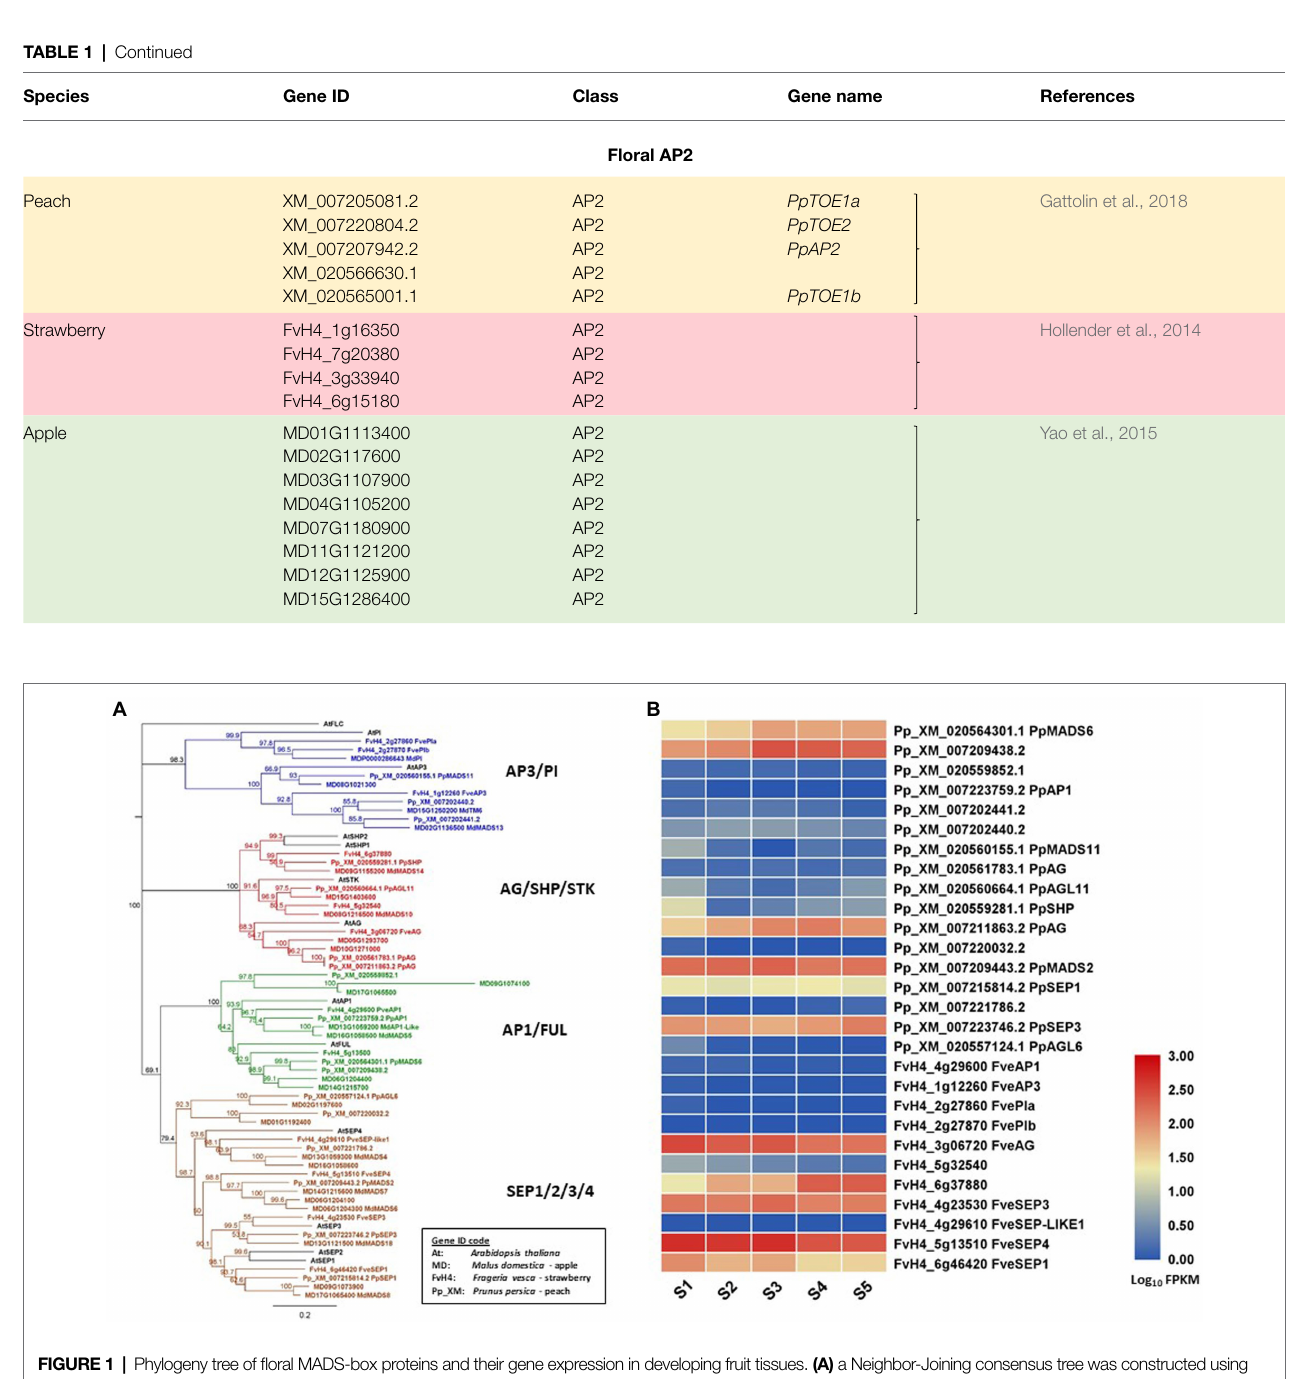
FIGURE 1 | Phylogeny tree of floral MADS-box proteins and their gene expression in developing fruit tissues. (A) a Neighbor-Joining consensus tree was constructed using Geneious software (v10.0.9) with 1,000 bootstrap replicates after protein sequences were aligned using Geneious Alignment software (v10.0.9). MADS-box protein sequences downloaded from the reference genome of apple (Daccord et al., 2017), peach (Verde et al., 2013), strawberry (Edger et al., 2017), and Arabidopsis. The Arabidopsis protein IDs are AT1G69120.1 (AtAP1), AT5G60910.1 (AtFUL), AT5G20240.1(AtPI), AT3G54340.1 (AtAP3), AT4G18960.1 (AtAG), AT3G58780.1 (AtSHP1), AT2G42830.1 (AtSHP2), AT4G09960.1 (AtSTK), AT5G15800.1 (AtSEP1), AT3G02310.1 (AtSEP2), AT1G24260.1 (AtSEP3), AT2G03710.1 (AtSEP4), and AT5G10140.1 (AtFLC). (B) a heatmap shows the expression patterns of floral MADS-box genes in fruit tissues of peach and strawberry at five developmental stages (S1-S5) based on previously published RNA-seq